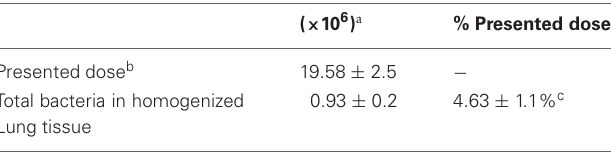
Table 2 | Lung dose (deposited dose) determined by analysis of homogenized lung tissue.